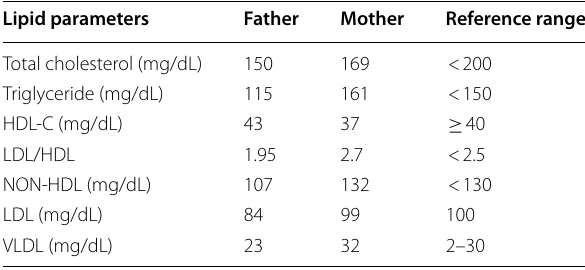
Table 2 Lipid parameters of the patient’s